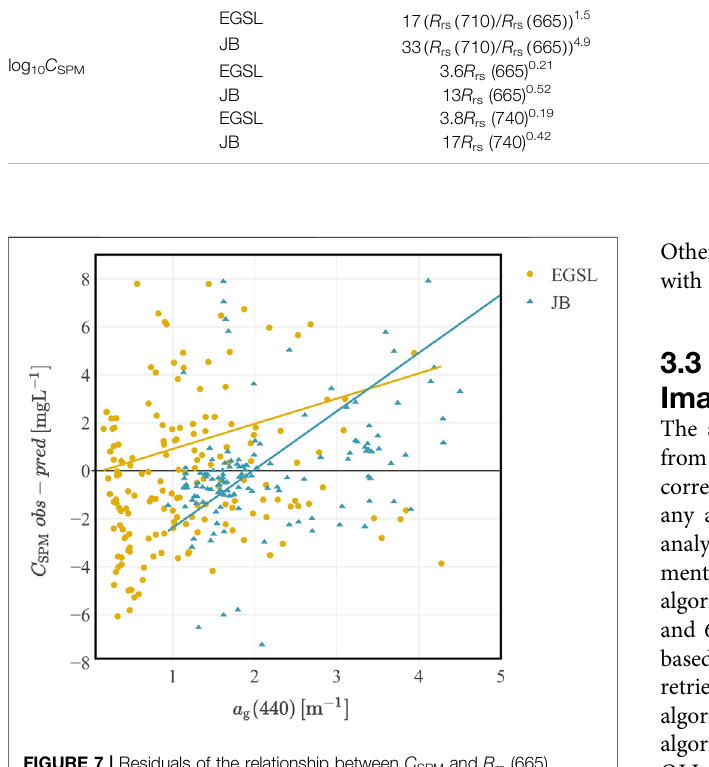
Frontiers in Remote Sensing |